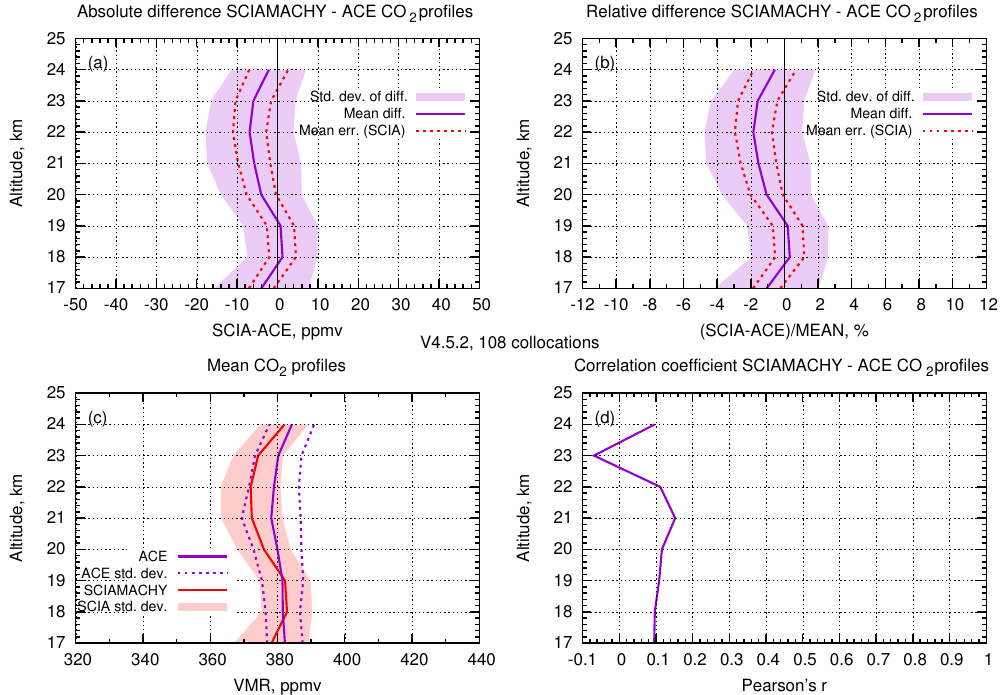
Figure 11. Same as Fig. 8, but for comparison of retrieved SCIAMACHY CO 2 profiles (ONPD V4.5.2, red) with ACE-FTS CO 2 after Sioris et al. (2014)